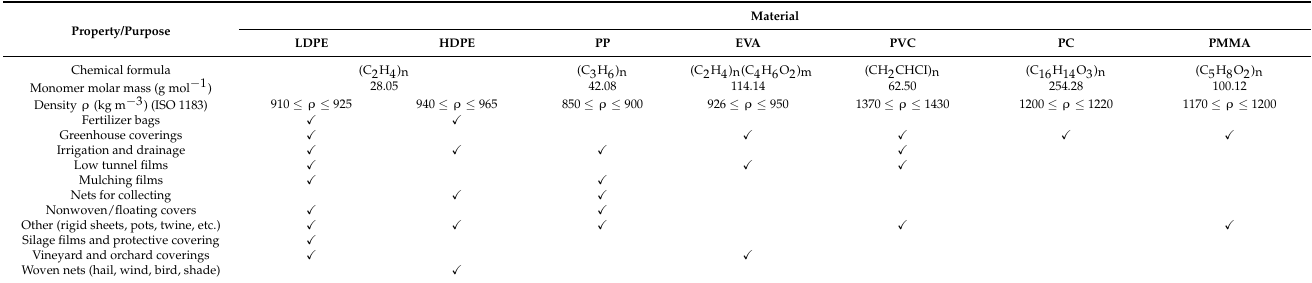
Table 1. Characteristics and purposes of the most-used petroleum-based plastics in agriculture. Adapted and modified from Scarascia-Mugnozza et al. [42]. LDPE: low density polyethylene; HDPE: high density polyethylene; PP: polypropylene; EVA: ethylene vinyl acetate; PVC: polyvinyl chloride; PC: polycarbonate; PMMA: